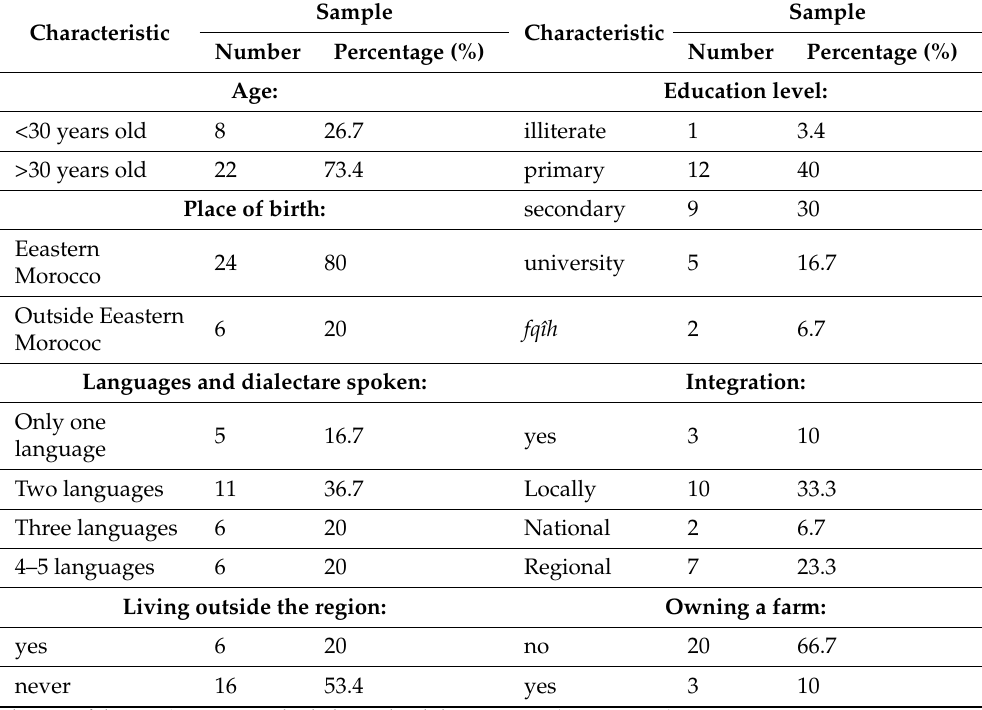
Table 1. Demographic information of all traditional healers